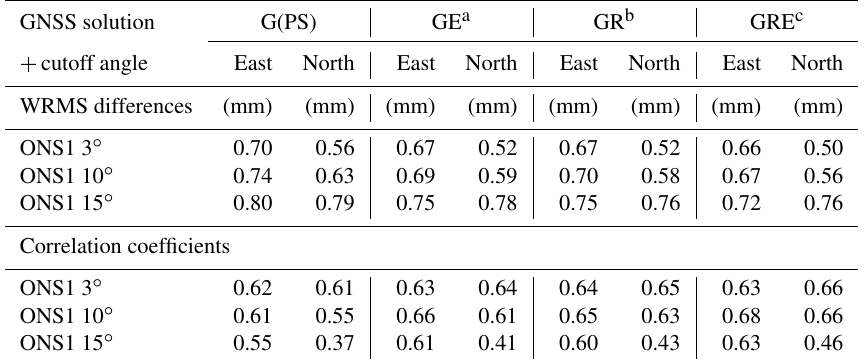
Table 2. The WRMS differences and correlations of the east and north gradients, obtained from different satellite constellations, relative to the WVR data. GNSS solution G(PS) GE a GR b GRE c + cutoff angle East North East North East North East North WRMS differences (mm)